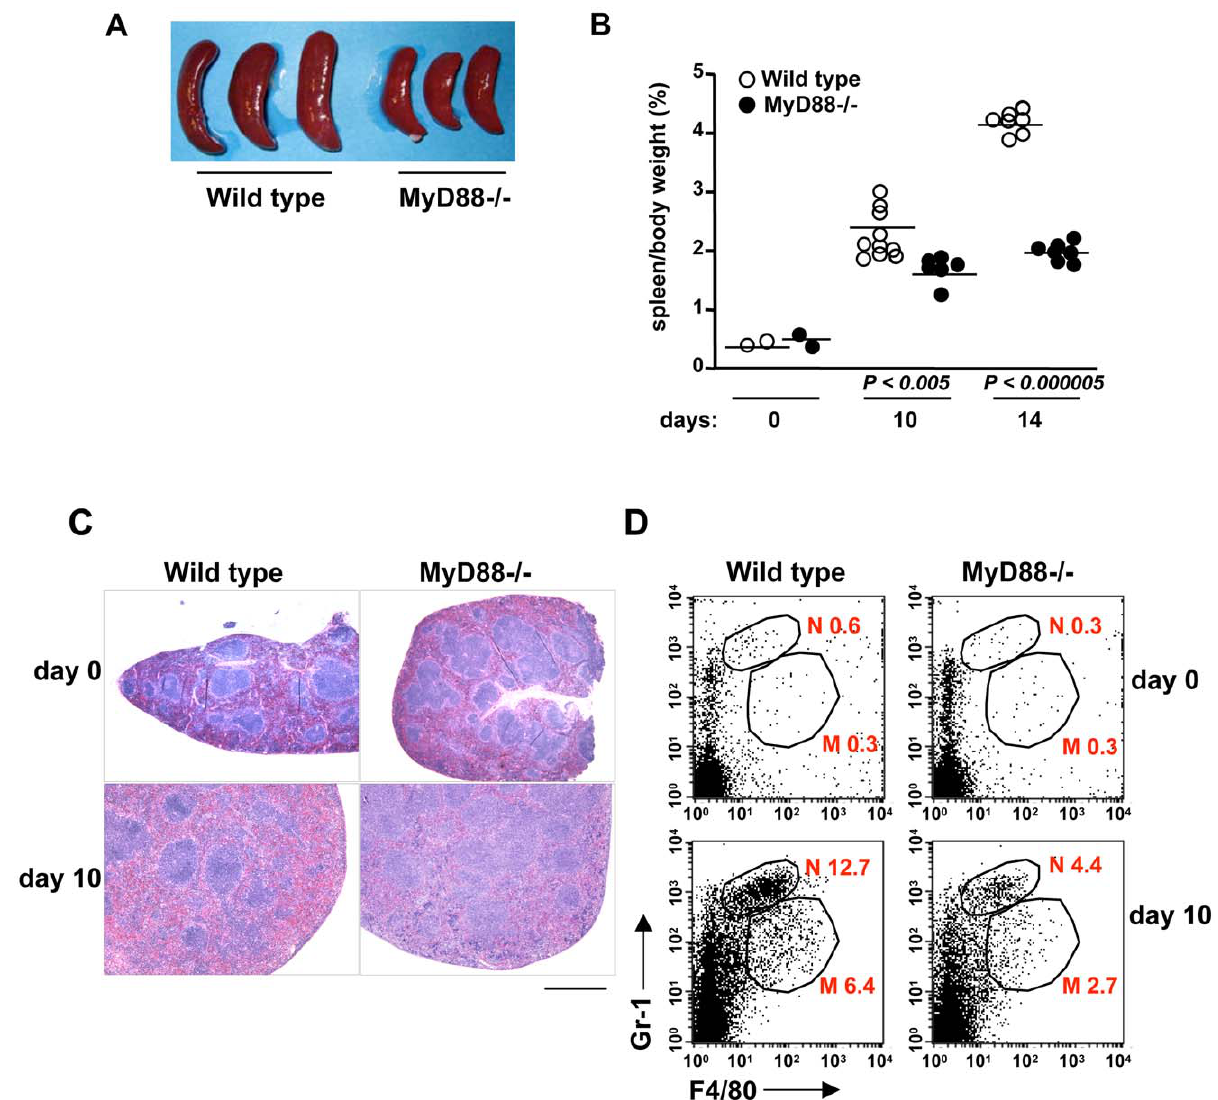
Figure 2. MyD88-deficient mice exhibited milder splenomegaly and leukocyte infiltration upon E.muris infection. Wild-type ( n =10 at day 10, n =7 at day 14) and MyD88-deficient mice ( n =6 at day 10, n =7 at day 14) were infected with E. muris i.p. for 10 and 14 days. (A and B) MyD88-deficient mice demonstrated reduced splenomegaly. Spleens were removed from the mice 10 days after E. muris infection and photographed in A. (B) Spleen weight was measured and normalized to body weight. A single circle represents an individual animal, and lines indicate the mean values. P -values were determined by Student’s t -test (Wild type vs. MyD88-/-). (C) Spleens from infected mice were H&E-stained and photographed. Scale bar, 1 mm. (D) Reduced recruitment of neutrophils and macrophages in E. muris -infected MyD88-deficient mice. Surface expression of Gr-1 or F4/80 from total splenocytes was analyzed by flow cytometry. Numbers beside outlined areas indicate the percentage of Gr-1 + or F4/80 + cells among total splenocytes. N, neutrophils; M, macrophages. Data are representative of at least three independent experiments in A–D.